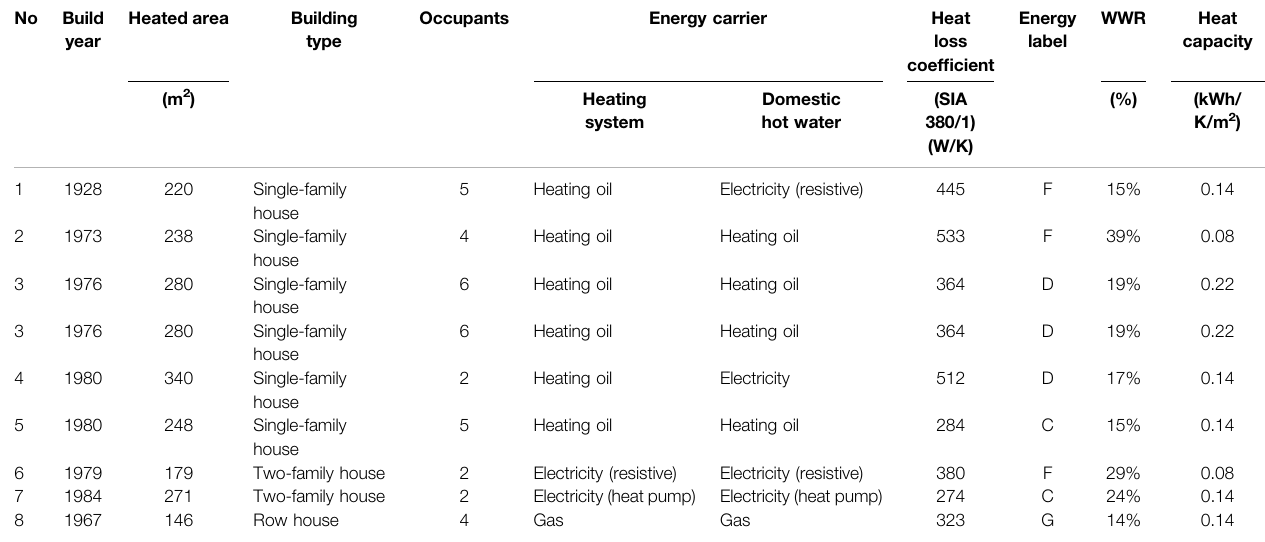
TABLE 1 | Characteristics of the eight buildings selected for the case